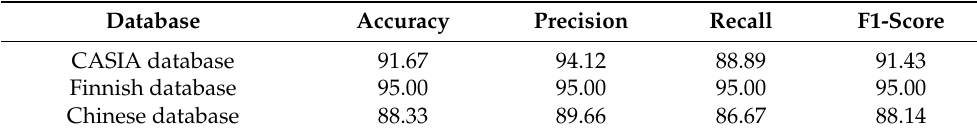
Table 2. Emotion recognition results based on the three databases (%).